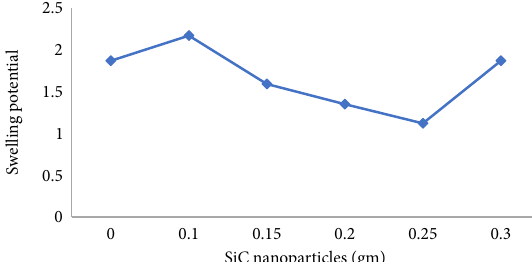
Figure 2. Effect of SiC nanoparticles on swelling potential of the soil